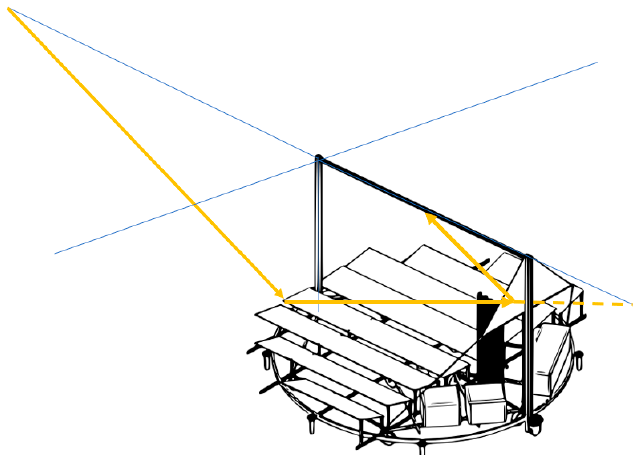
Figure 17. Illustrative diagram of the solution proposed to avoid end losses.